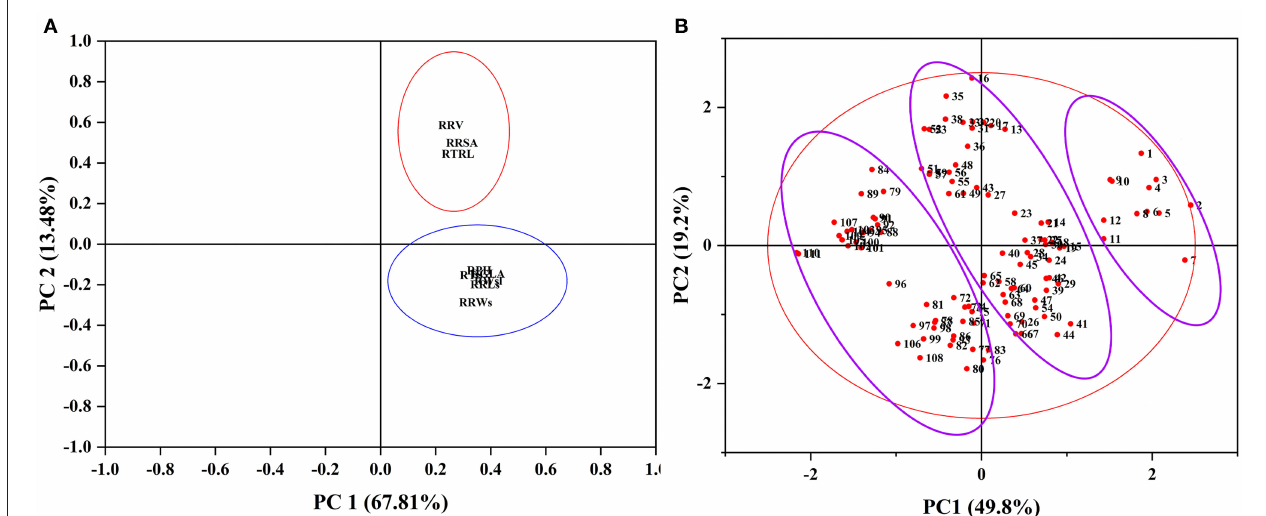
FIGURE 2 | PCA of all traits and alkali tolerance from 111 genotypes at the seedling stage. PCA, principal component analysis. (A) Principal component analysis of all traits. (B) Principal component analysis of 111 genotypes. RPH, relative plant height; RTS, relative stem thickness; RGLA, relative green leaf area; RRLs, relative root length at the seedling stage; RWsl, relative stem and leaf fresh weight; RRWs, relative root fresh weight at the seedling stage; RTRL, relative total root length; RRSA, relative root surface area; RRV, relative root